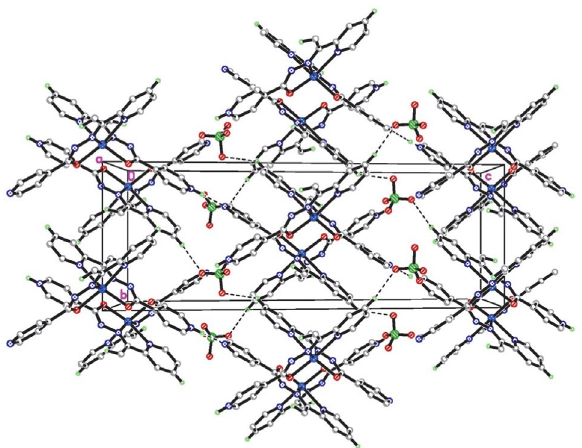
Fig. 4. Molecular packing structure of complex 2 , with hydrogen bonds drawn as dashed lines.